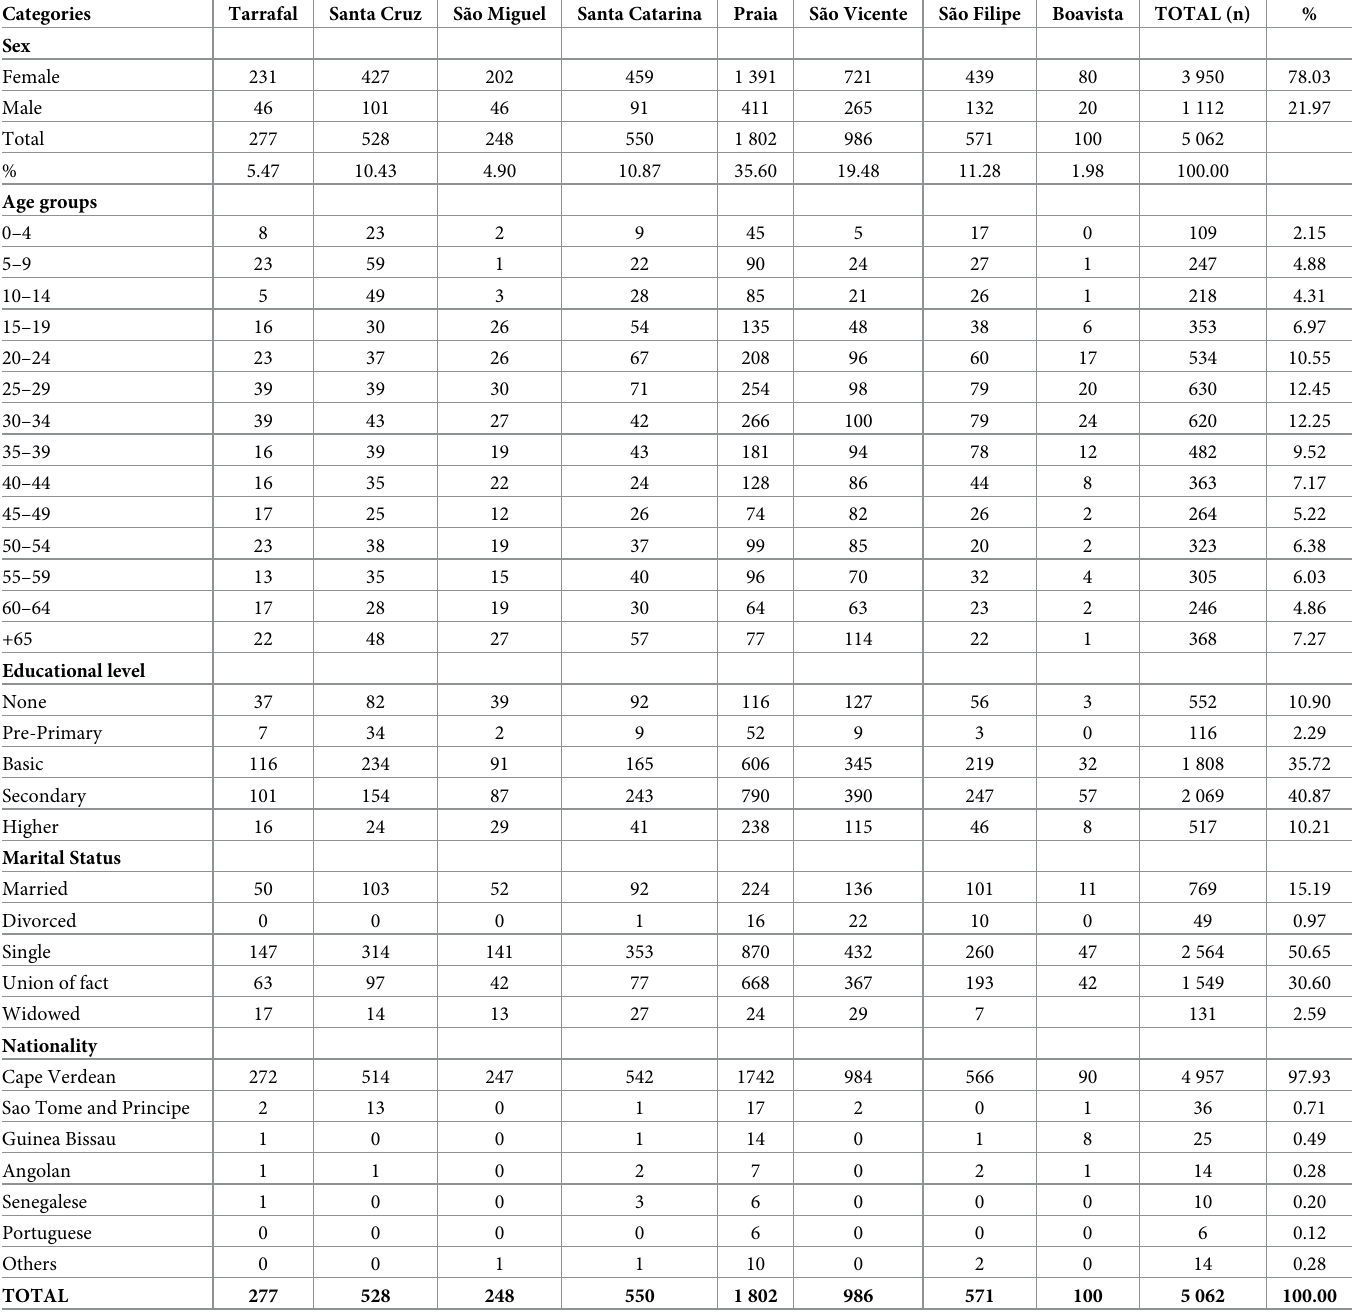
Table 1. Sociodemographic characteristics of study